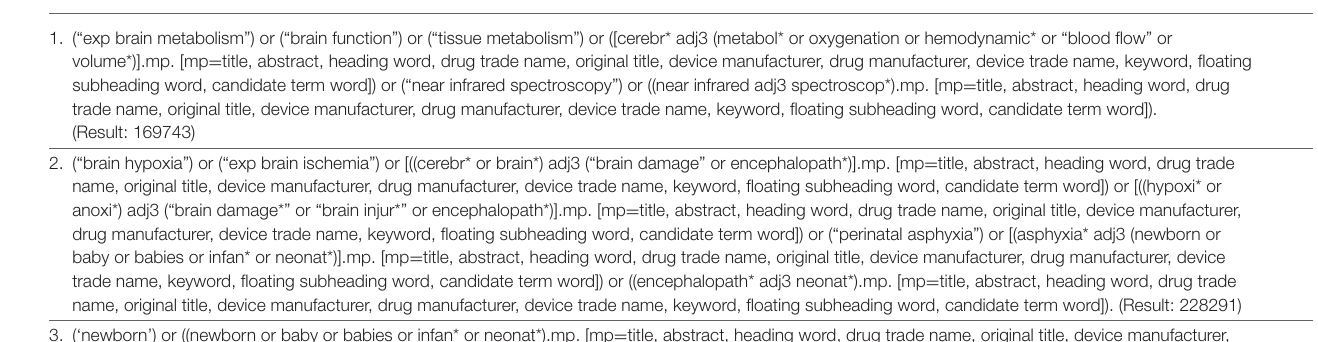
TABLE 1 | Search strategy for the systamtic review on EMBASE. Search strategy used for systematic review: